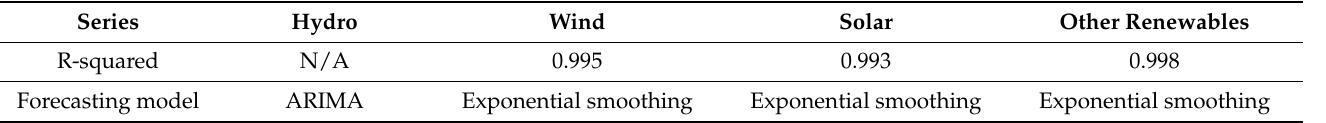
Table 2. R-squared and applied model. Source: own elaborations.